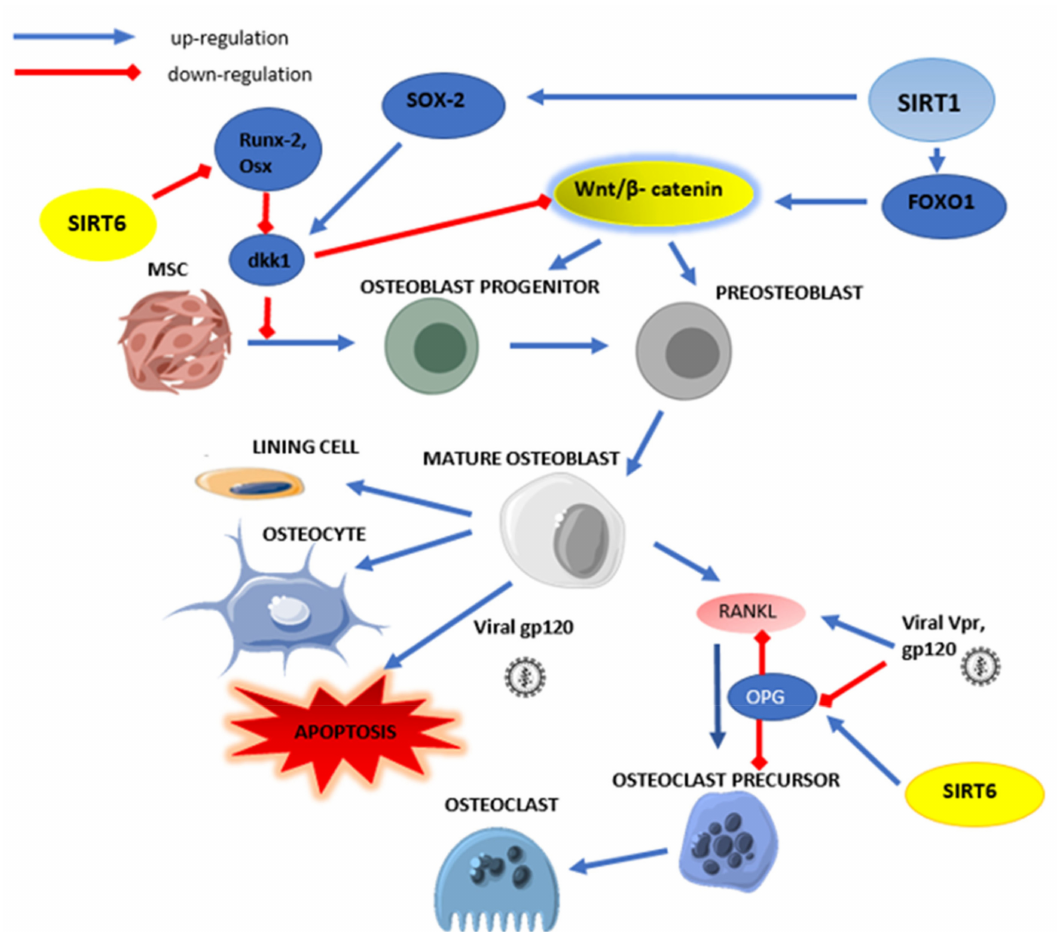
Figure 5. Scheme of connection between sirtuins, HIV infection and bone metabolism. SIRT1 deacetylates and up-regulates SOX2, the main factors maintaining the self-renewal and ability to differentiate mesenchymal stem cells in osteoblasts. FOXO1 deacetylation by SIRT1, up-regulates the differentiation of preosteoblast and osteoblast progenitor into osteoblasts. SIRT6 down-regulates Runx2 and Osx genes, responsible for inhibiting blastogenesis and the transition of osteoblasts to osteocytes. SIRT6 up-regulates OPG-RANKL inhibitor, decreasing bone resorption. RANKL, receptor activator for nuclear factor κ B ligand; OPG, osteoprotegerin; FOXO1, forkhead box protein O1; SOX-2, SRY-Box transcription factor 2; Runx2, runt-related transcription factor 2; DKK-1, Dickkopf-related protein 1; MSC, mesenchymal stem